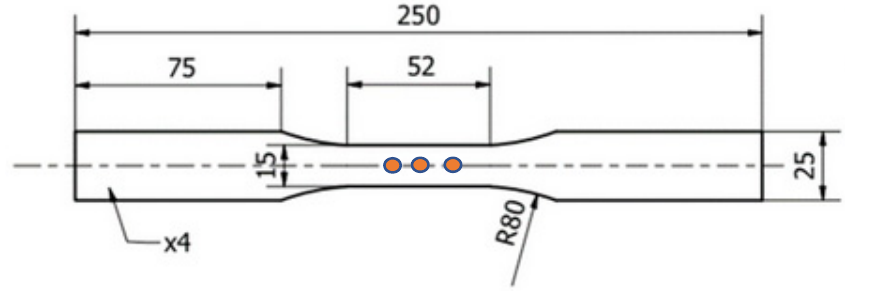
Figure 2. Geometry of the specimen used for uniaxial tensile and standard fatigue tests with marked areas of EC measurements (units in mm).